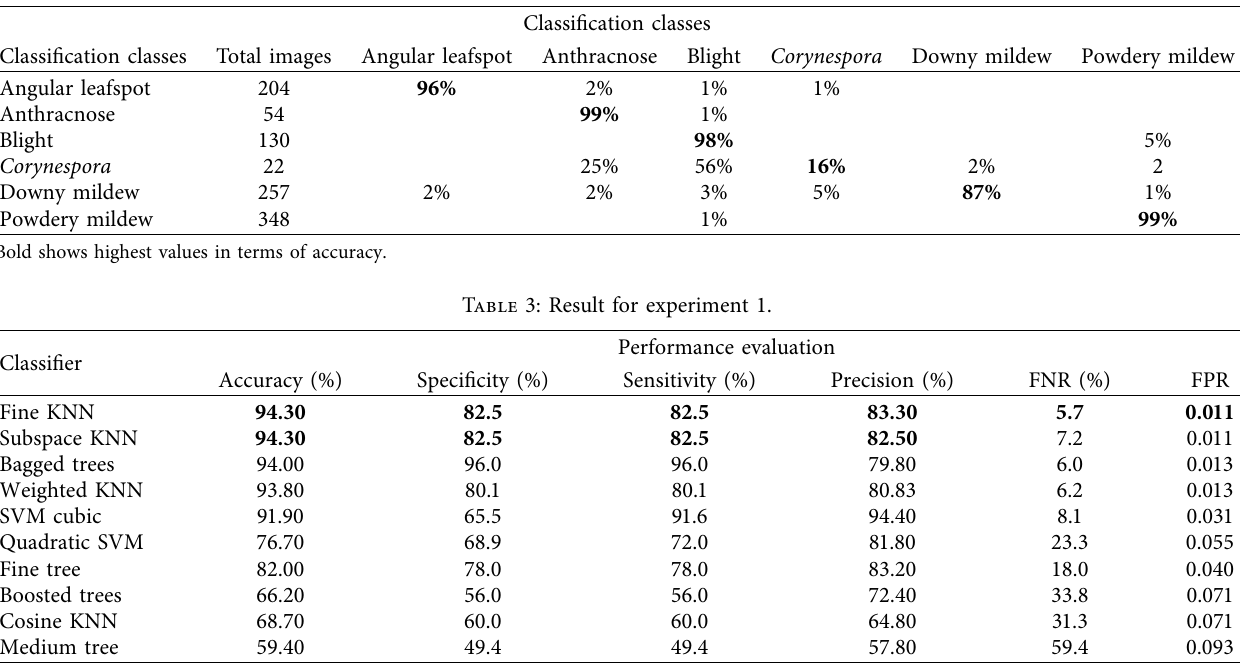
Figure 9: Graphical representation of classification methods in terms of accuracy and time for experiment 1. Table 2: Confusion matrix of cucumber leaf dataset of test 1 on ensemble fine KNN.